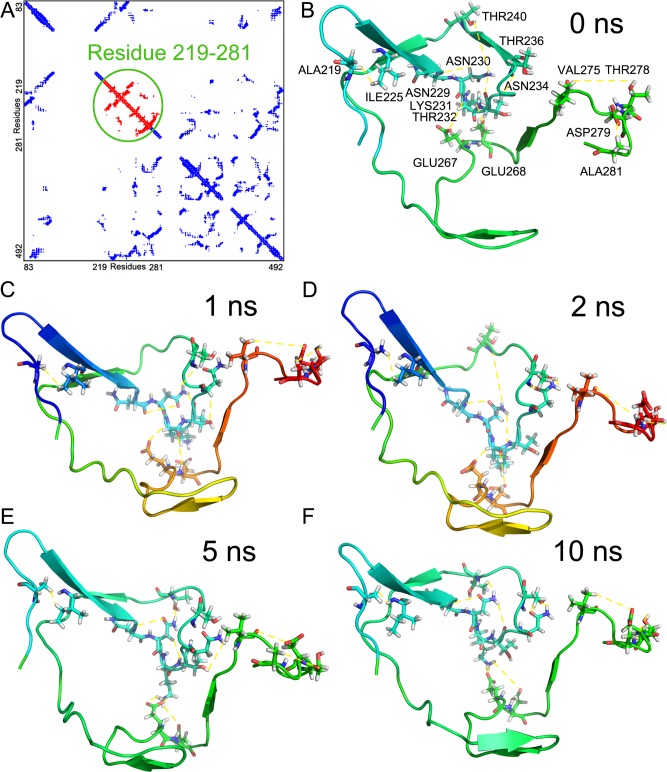
Interactions between coevolving residues in GP120.(A) The contact (hydrogen bonds) maps from molecular dynamics simulation of GP120; (B-F) Snapshots of the interactions between coevolving residues in protein sector of gp120 during molecular dynamics simulations of 0 ns, 1 ns, 2 ns, 5 ns, and 10 ns separately.